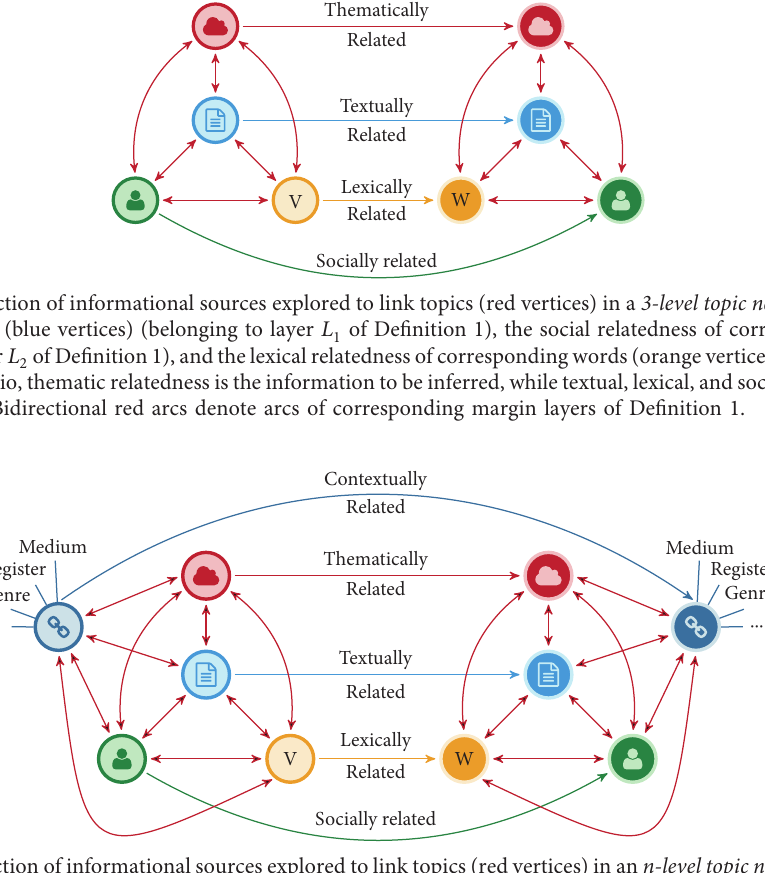
Figure 12: Schematic depiction of informational sources explored to link topics (red vertices) in an n-level topic network , n > 3, as a function of the textual relatedness of texts (blue vertices) (belonging to layer L of Definition 1), the social relatedness of corresponding authors 1 of Definition 1), the lexical relatedness of corresponding words (orange vertices) (belonging to layer (green vertices) (belonging to layer L 2 L of Definition 1), and additional layers of contextual patterns concerning, for example, the underlying medium, genre, or register 3 instantiated by the texts under